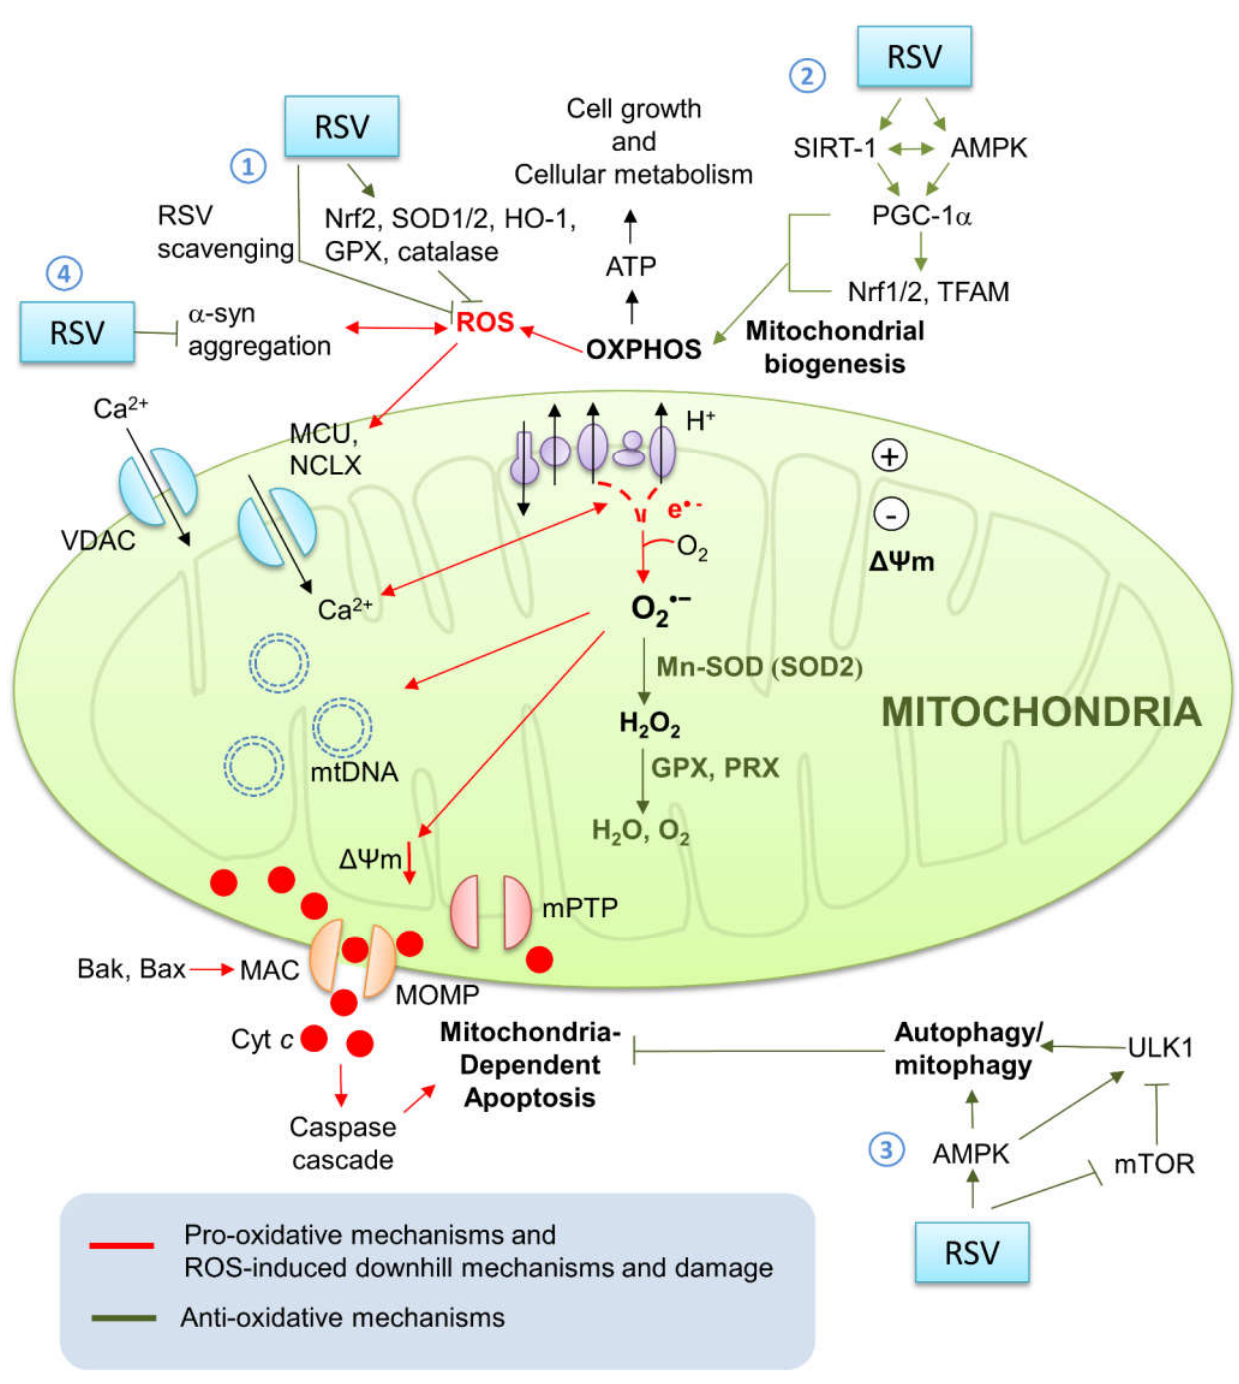
Figure 3. The involvement of mitochondria protection provided by resveratrol in PD pathogenesis. Normal functioning of the mitochondrial bioenergetics involves the mitochondrial OXPHOS machinery on the inner membrane transforming energy into the form of ATP in order to fuel cellular energy needs. In the process of OXPHOS, electrons leak out mainly from mitochondrial complexes I and III, producing the byproducts O 2 •− . The radicals may cause dyshomeostasis of Ca 2+ , damage to mtDNA, and, under overwhelming oxidative stress, even mitochondria-dependent apoptosis. Mitochondrial antioxidative mechanisms include the ROS-scavenging enzyme Mn-SOD (or SOD2), the major intracellular thiol